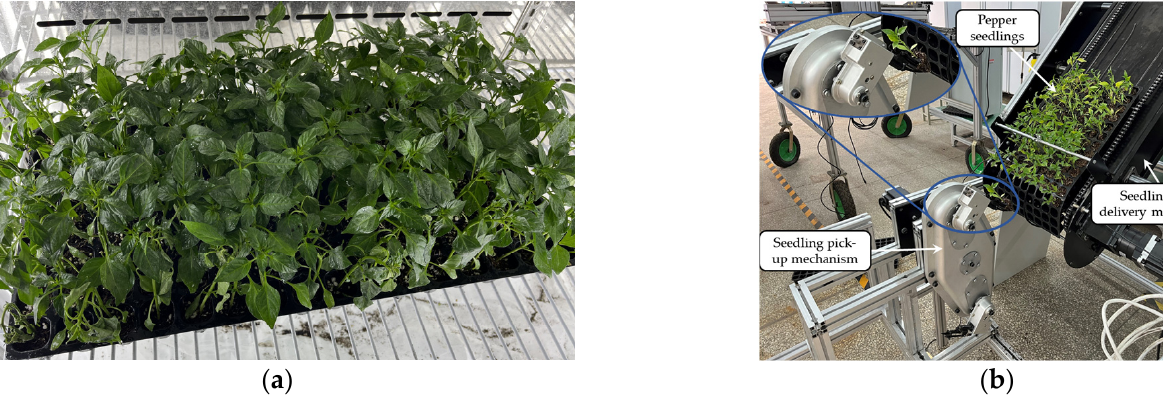
Figure 13. Pepper seedling sampling test: ( a ) A tray with 128 pepper seedlings; ( b ) Seedling picking test bench.